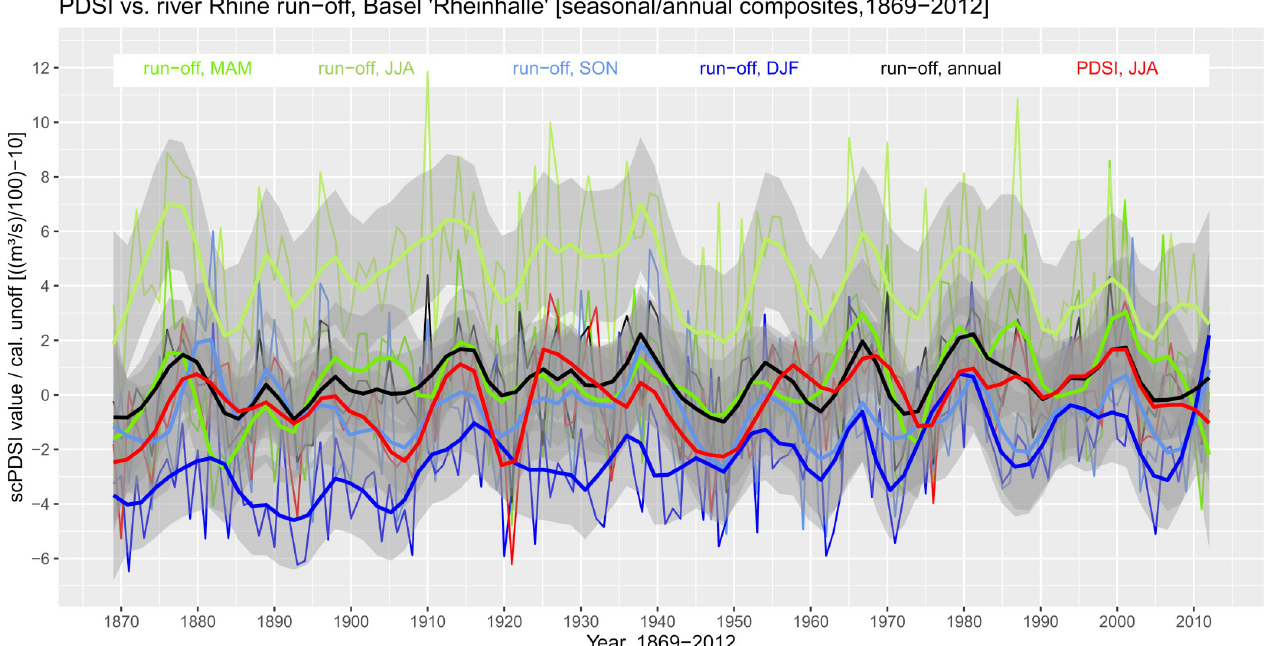
Fig 5. Calibration data for river Rhine run-off at Basel. Seasonal composites and annual mean river Rhine run-off characteristics at Basel, Rheinhalle, over the period 1869–2012 compared to mean PDSI in the river catchment (run-off adjusted as ((m 3 /s)/100)-10; annual mean composites of MAM (March-May), JJA (June-August), SON (September-November), DJF (December, January (yr+1), February (yr+1); loess smoothing parameter = 0.1; grey shade = 95% confidence level).